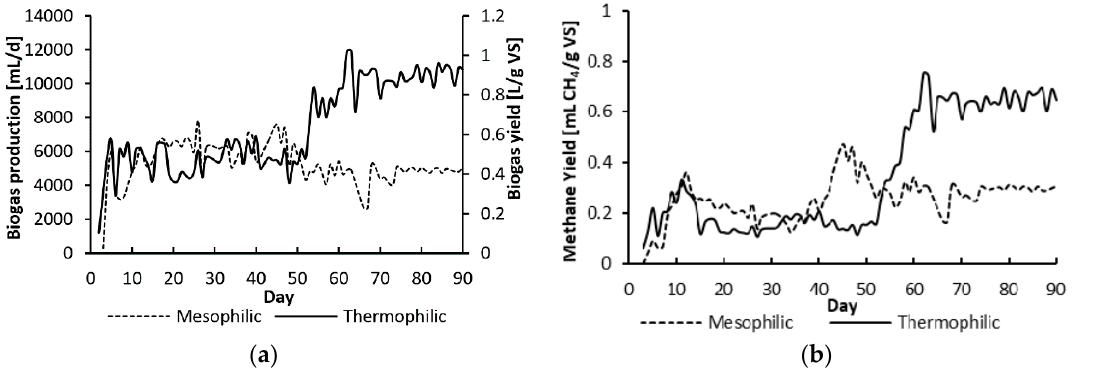
Figure 3. Biogas production ( a ) and methane yield properties ( b ) obtained during the anaerobic digestion of ORF.